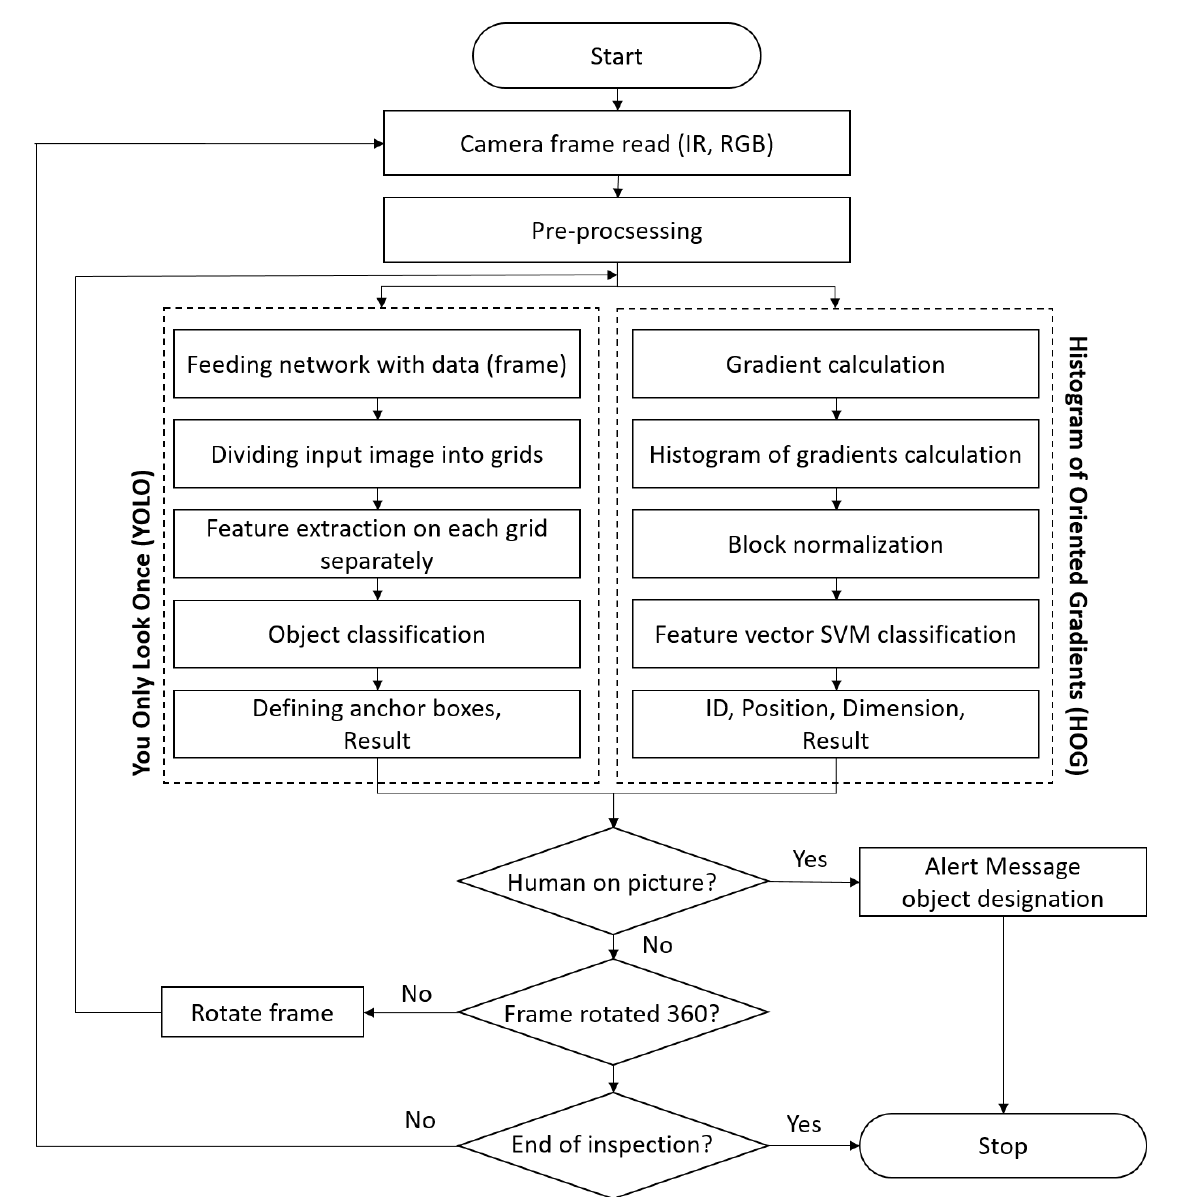
Figure 9. The scheme of presented